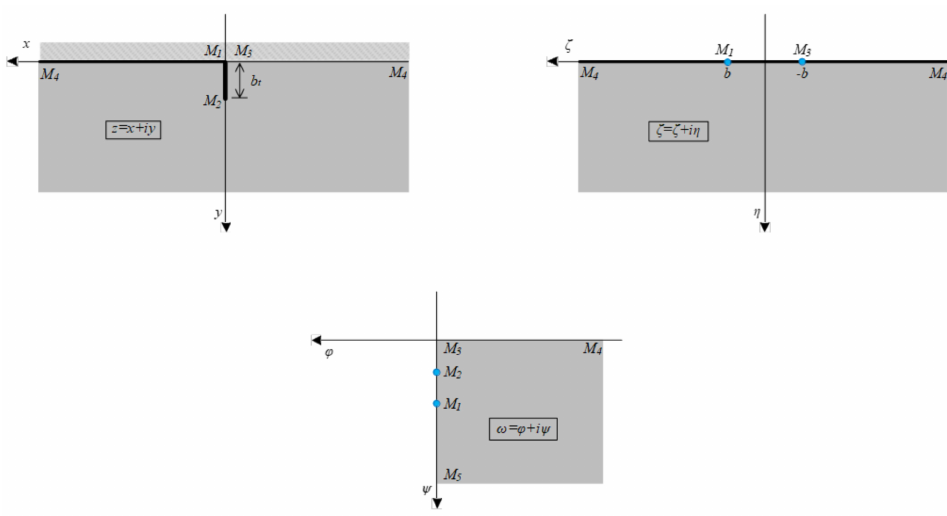
Figure 3. Conformal mapping schemes for the pipe tip